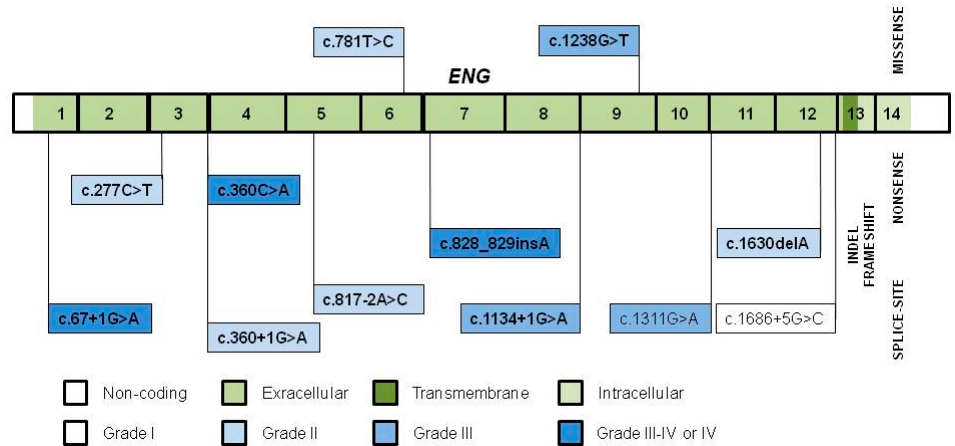
Figure 3. The grade II to IV founder variants in the exons and flanking intronic regions of ENG . Pathogenic variants are indicated in bold.